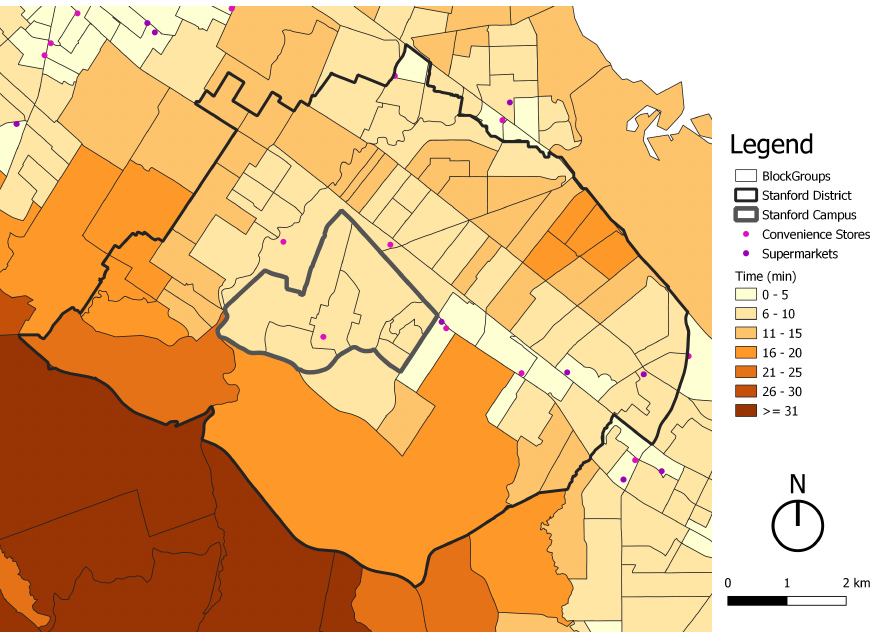
Figure 9. Stanford District average travel time to the closest supermarket or convenience store by